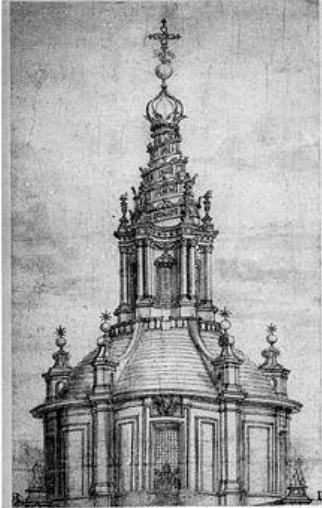
Fig. 17 San Lorenzo Church (Guarini, Turin, 1668-1687) Borromini shapes undulating architraves, skewed arches and oblique forms (Fig. 18).